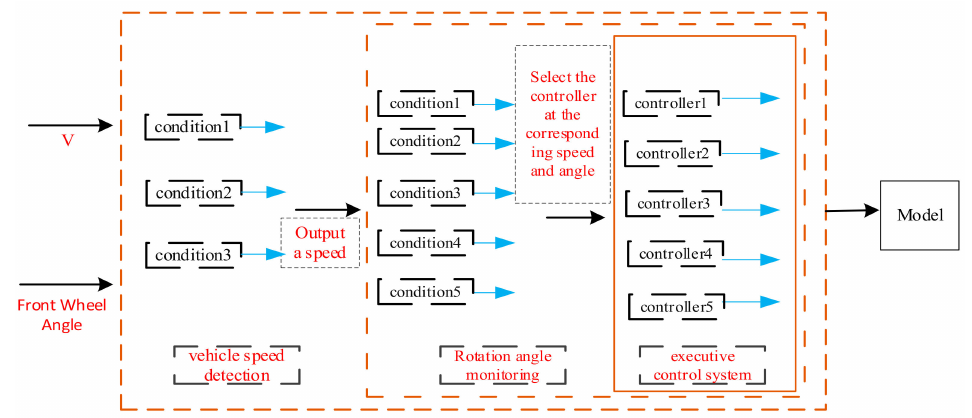
Figure 2. Control system structure.